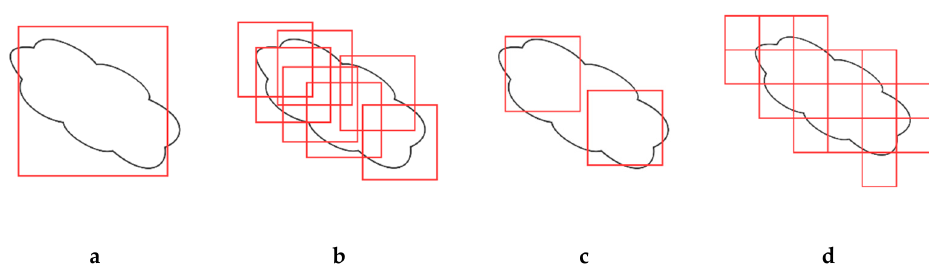
Figure 22. The methods to place patches of different approaches: ( a ) Fu et al.; ( b ) Zhao et al.; ( c ) Zhang et al.; and ( d ) ours. (black lines represent image objects and red lines represent patches).